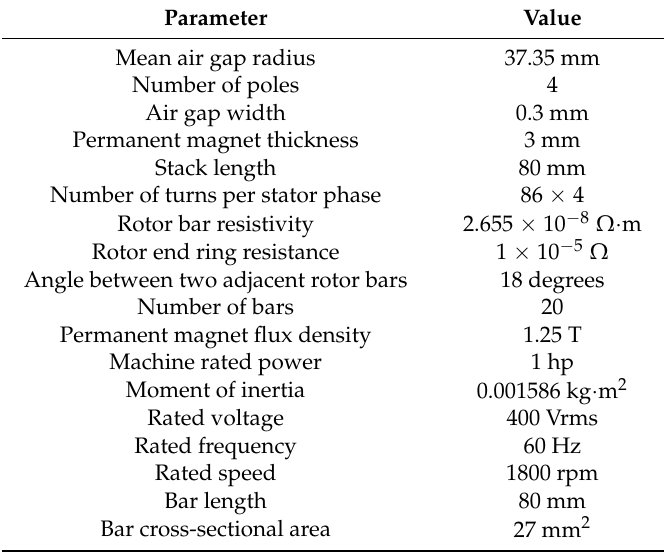
Table 1. The parameters of the tested motor.